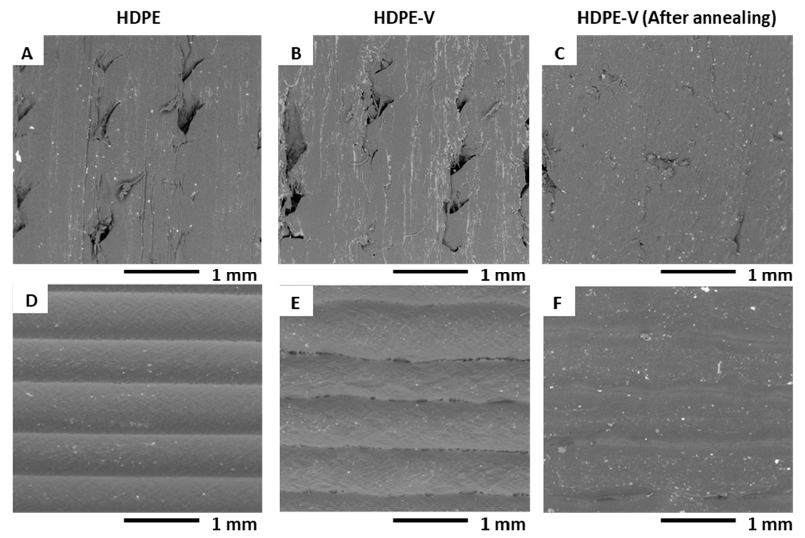
Figure 10. SEM imaging of the samples shown in Figure 2B: ( A – C ) 3D-printed samples normal to the print direction (X-Z view in Figure 2B), and ( D – F ) 3D-printed samples parallel to the print di- rection (Y-Z view in Figure